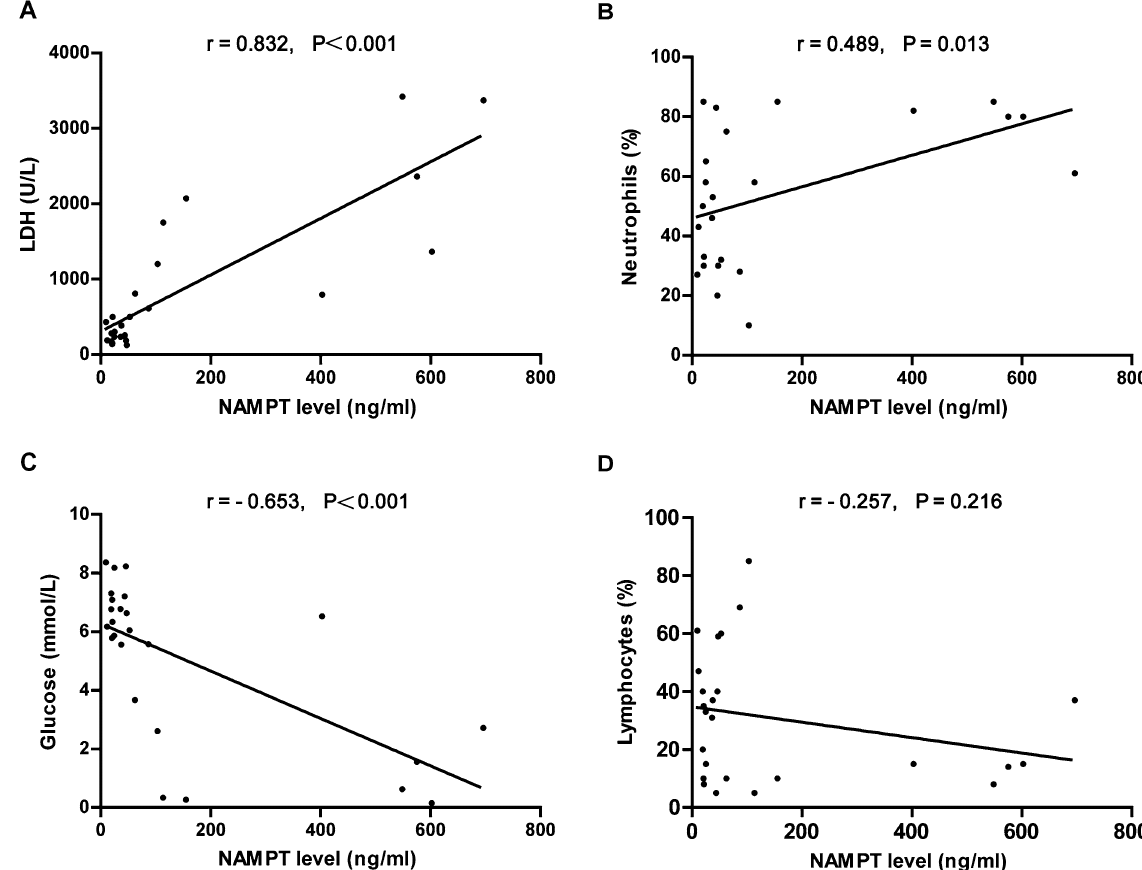
Figure 3. Correlation between pleural fluid NAMPT levels and LDH levels, neutrophil percentage, glucose levels, and lymphocyte percentage in parapneumonic